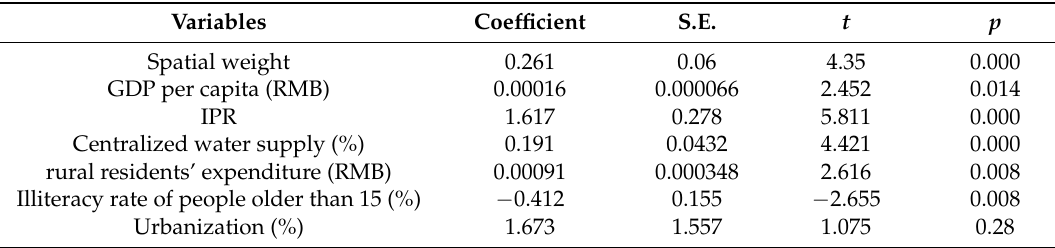
Table 3. Results of spatial panel model using socio-economic